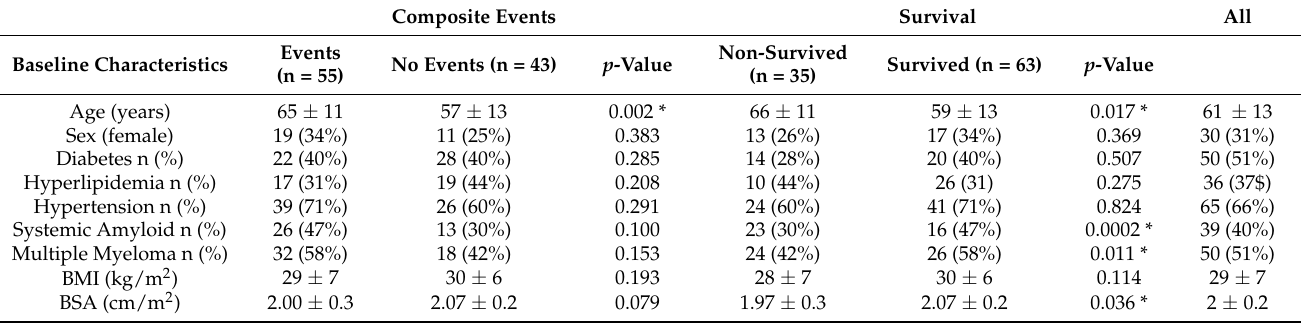
Table 1. Patients’ demographics stratified by two endpoints: time to composite events and survival.